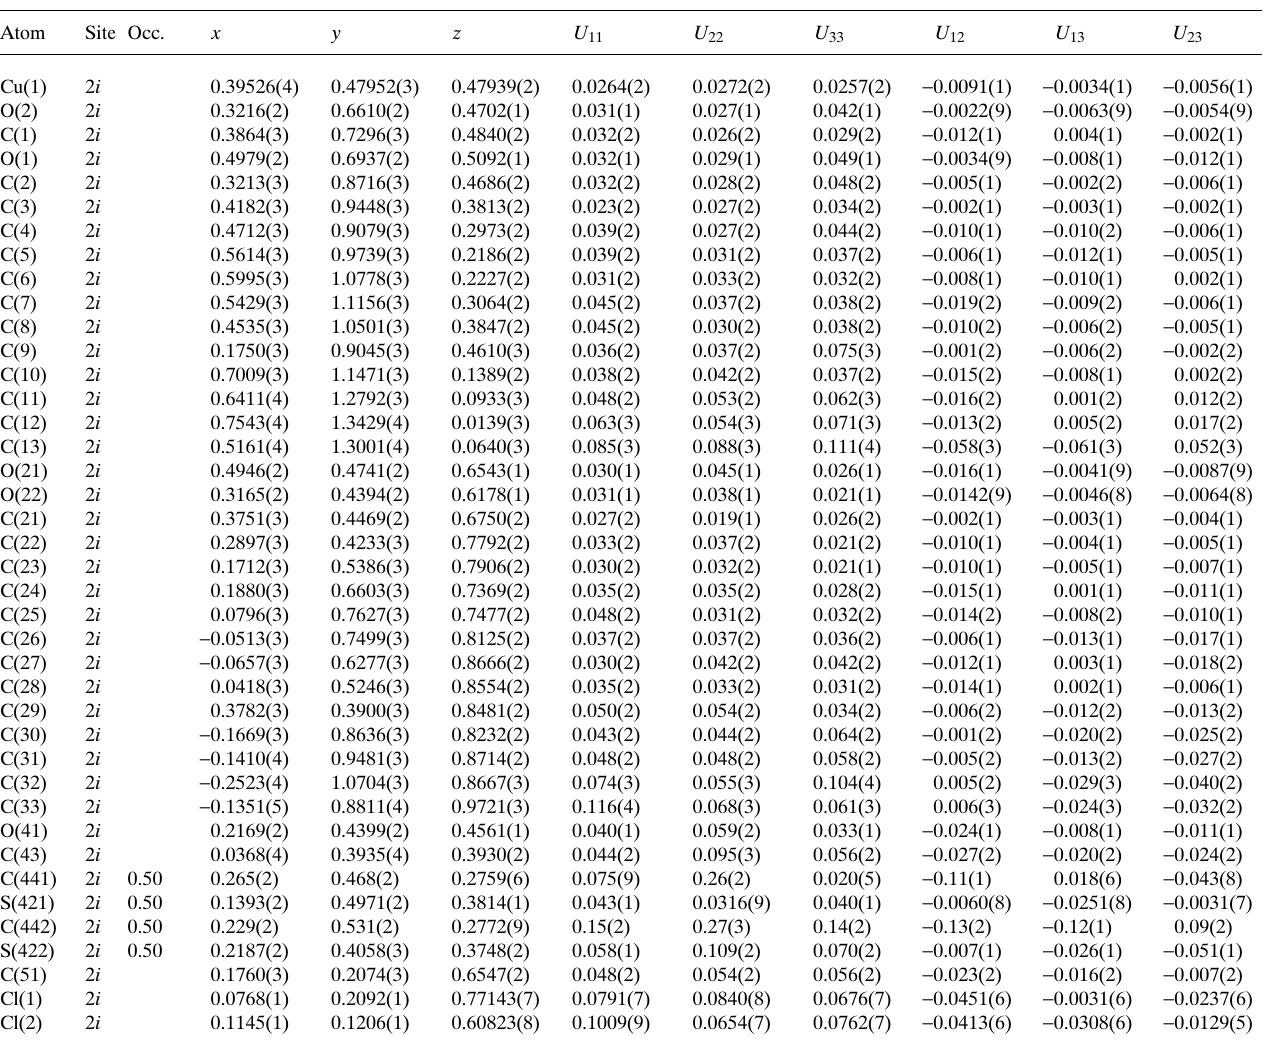
Table 6. Atomic coordinates and displacement parameters (in Å 2 )